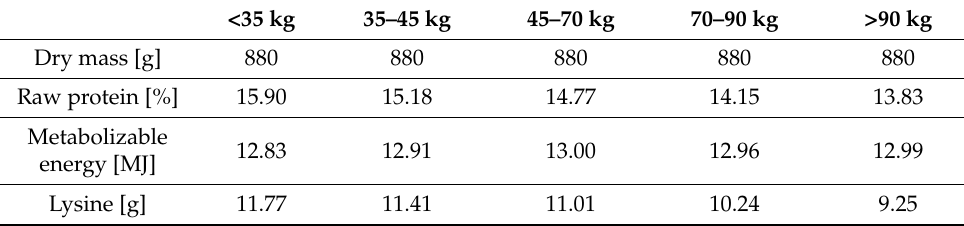
Table 1. Composition of the feeding stuff dependent on animal weight for a dry mass of 880